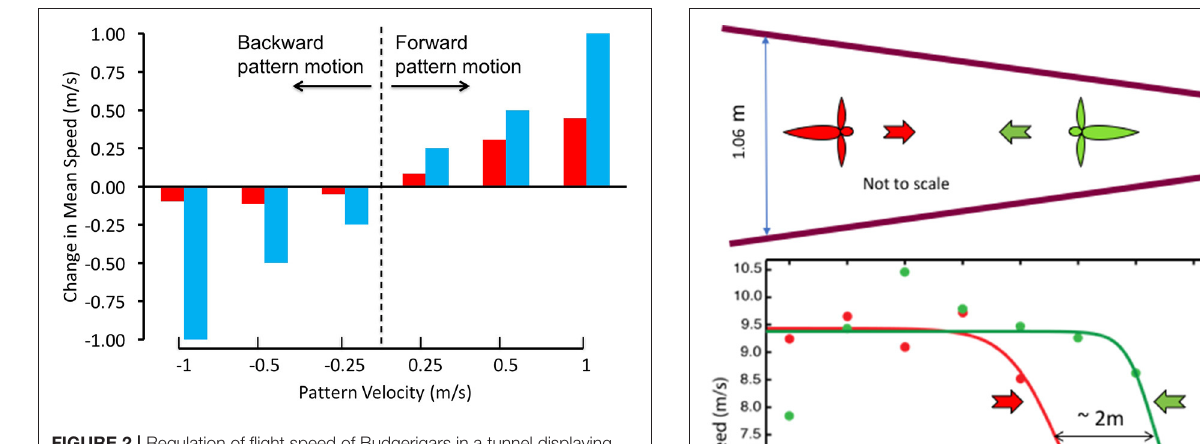
FIGURE 2 | Regulation of flight speed of Budgerigars in a tunnel displaying moving gratings on the walls. The red bars denote the change in flight speed induced by the moving gratings in comparison with stationary gratings, where positive pattern velocities represent grating motion in the birds’ flight direction and negative pattern velocities represent grating motion in the opposite direction. The blue bars represent the changes in flight speeds that would be expected if the Budgerigars matched the changes of their flight speed to the speeds of grating motion, i.e., if they held the rate of image motion constant in their eyes. Adapted with permission from Schiffner and Srinivasan (2015).